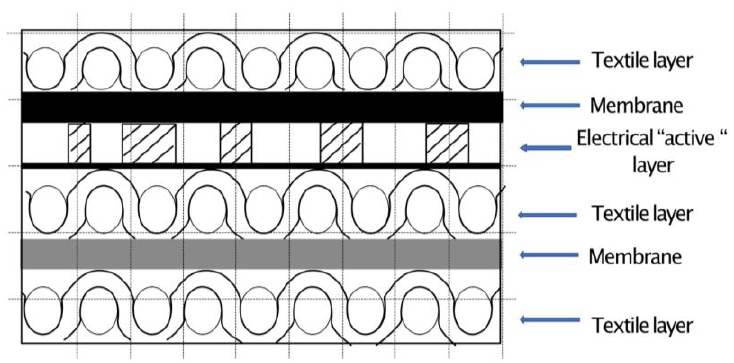
Figure 1. Schematics of the textile material structure in coronal